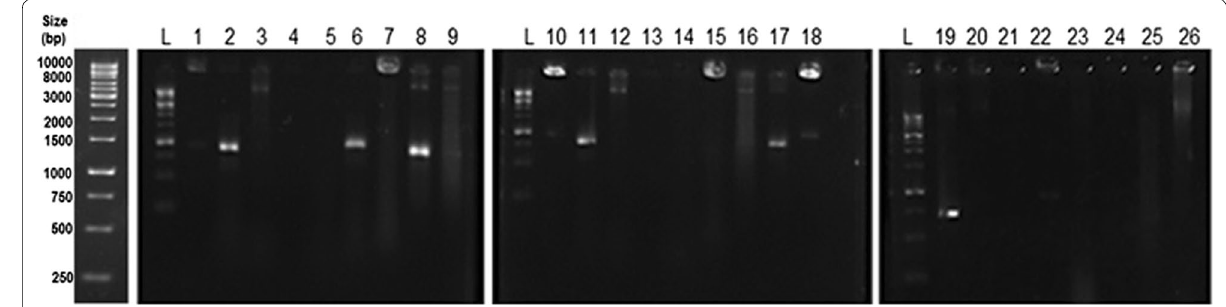
Fig. 1 PCR amplification of genomic DNA from isolated histamine utilizing strains, using HOD primers. The amplified primers in lanes 2, 6, 8, 11, 17, and 19 were considered as putative sequences related to HOD. L, one-kb DNA